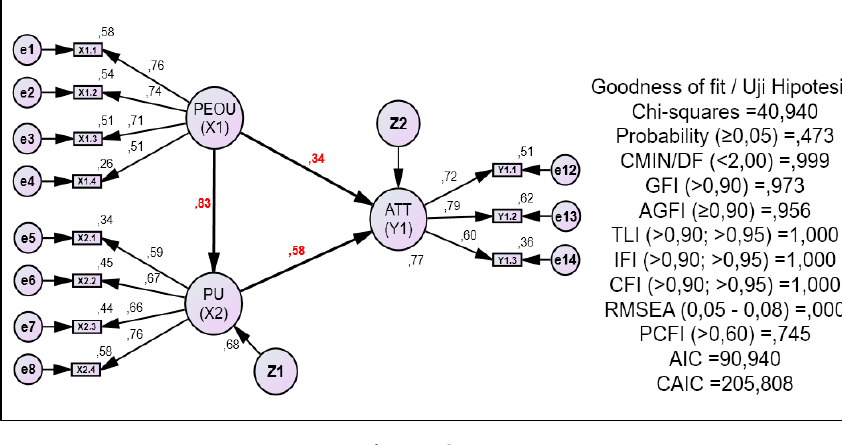
Figure 3. Measurement of Results of Full CFA Model